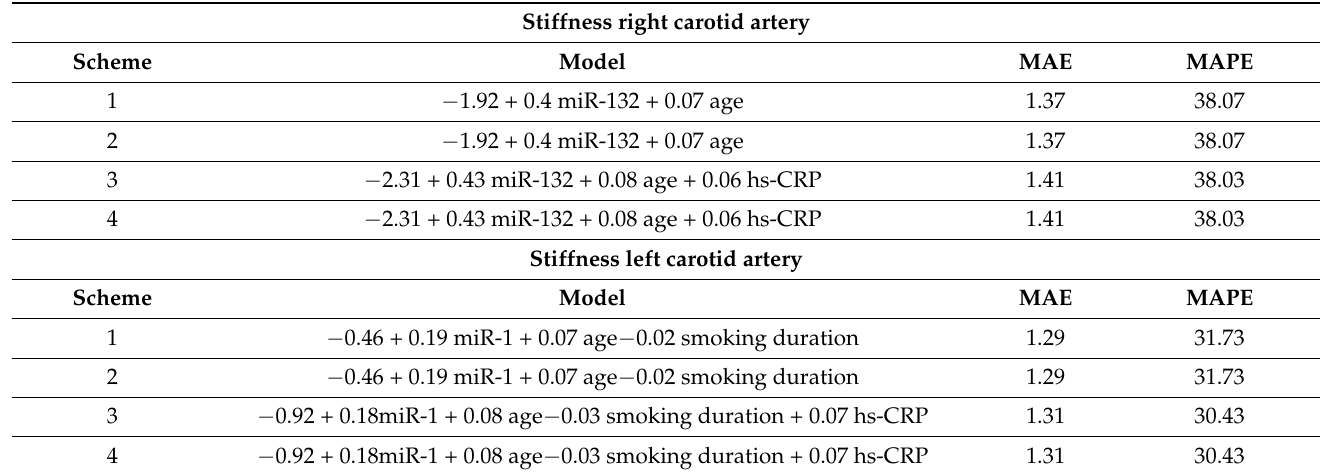
Table 8. Factors predicting carotid artery